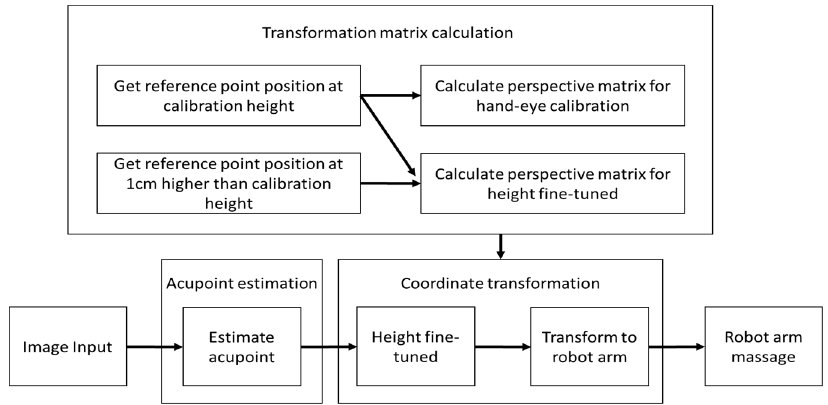
Figure 7. System components for robot arm acupuncture or massage.